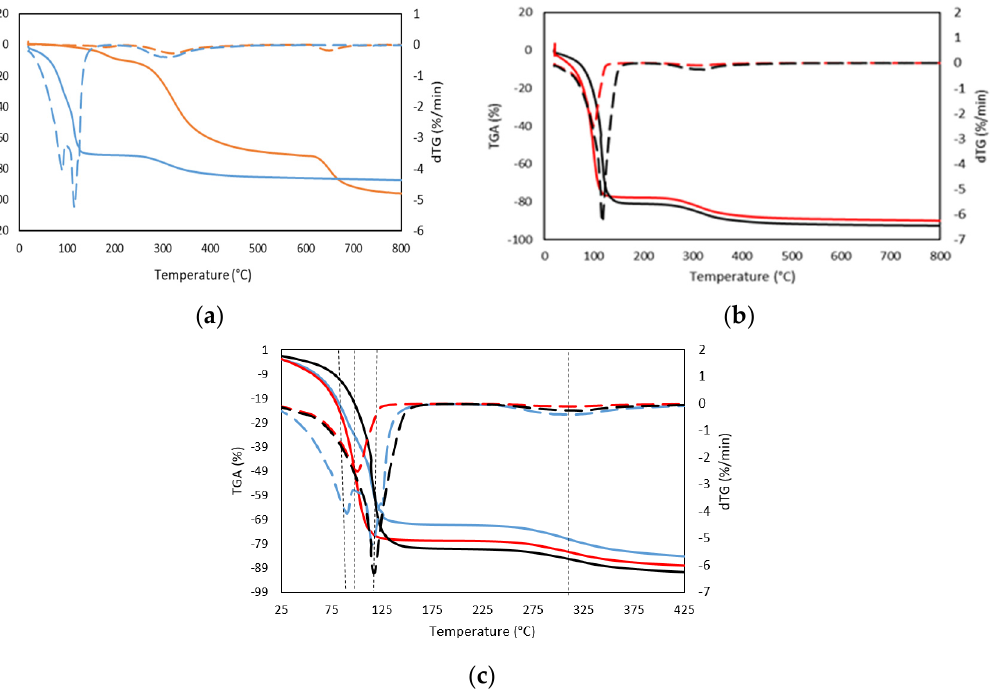
Figure 3. TGA thermogram (solid line, weight loss), and dTGA thermogram (dashed line, differential weight loss) obtained from TG curves of ( a ) ( - ) Dry GE ( - ) 25GE, ( b ) ( - ) 25GE/DOX ( - ) 25GE/Crocin, and ( c ) comparative plot of TGA thermogram (solid line, weight loss), and dTGA thermogram (dashed line, differential weight loss) of 25GE, 25GE/DOX and 25GE/Crocin. Table 3. Values obtained from TGA and DTGA analyses of Dry GE, 25GE, 25GE/DOX and 25GE/Crocin. Onset temperatures, T onset ; maximum temperatures, T max ; and weight loss (%) at 5 °C/min.